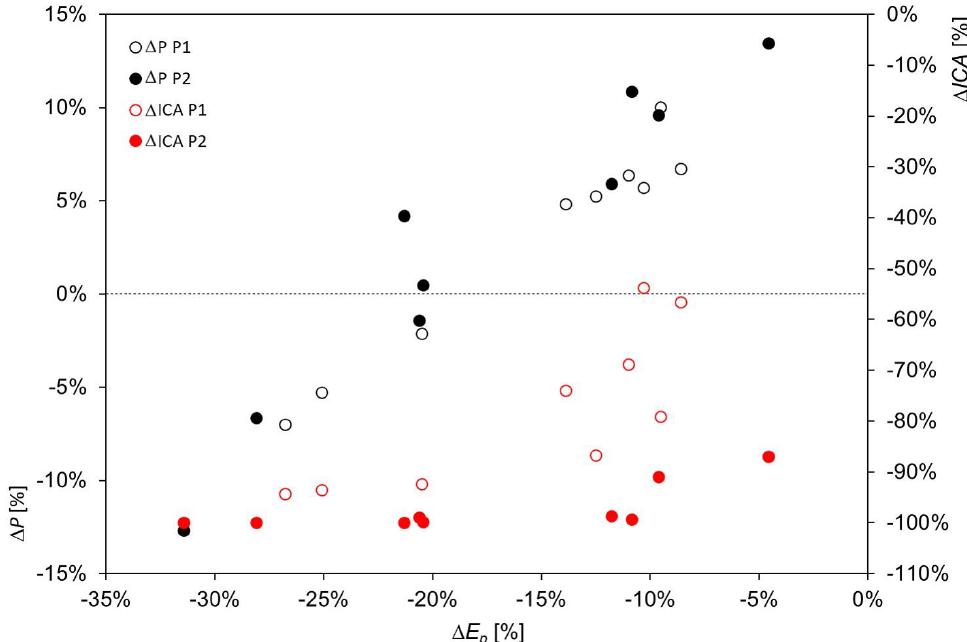
Figure 13. Sabbione reservoir. Energy production changes Δ Ep , against precipitation changes Δ P and ice cover changes ΔICA, in P1 (ICA in year 2051), and P2 (ICA in year 2092). Table 6. Correlation analysis of changes in energy production Ep against climatic and hydrologic drivers, yearly scale. Below diagonal, Pearson correlation coefficients. Significant ( = 5%) correlation coefficients are in bold. p- values are above the diagonal.